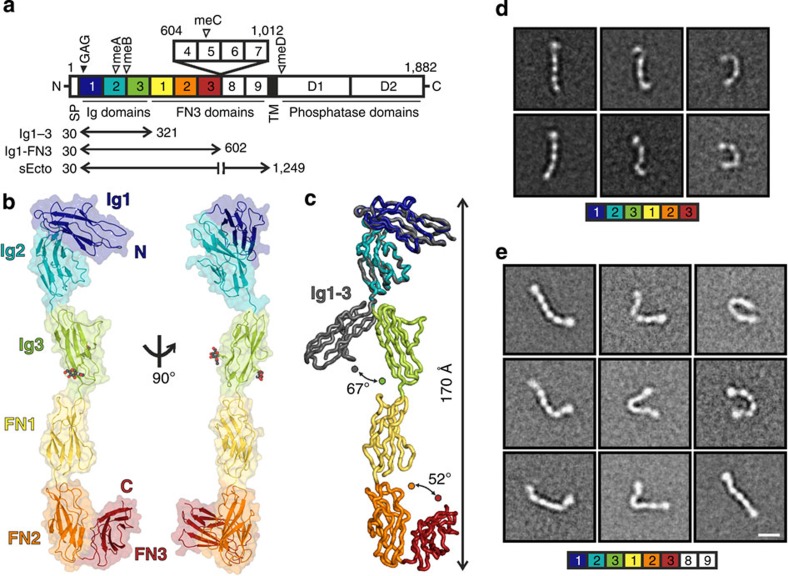
RPTPσ ectodomain flexibility.(a) RPTPσ domain organization. N, amino-terminus (extracellular); SP, secretion signal peptide; TM, transmembrane; C, C terminus (intracellular); Ig, immunoglobulin-like; FN, fibronectin type-III; GAG, glycosaminoglycan-binding site (filled arrowhead). Alternative splicing inserts: FN domains 4–7 and mini-exons A–D (open arrowhead). (b) Ribbon and surface representations of the human RPTPσ Ig1-FN3 crystal structure. N-linked glycans in atom representation. (c) Ig3 movement in Ig1-FN3 relative to Ig1–3 (grey, PDB ID: 2YD9) structure. Representative RPTPσ Ig1-FN3 (d) and RPTPσ sEcto (e) negative-stain electron microscopy class averages. Scale bar, 10 nm. Full sets of RPTPσ Ig1-FN3 and sEcto class averages are provided in Supplementary Figs 2 and 3.